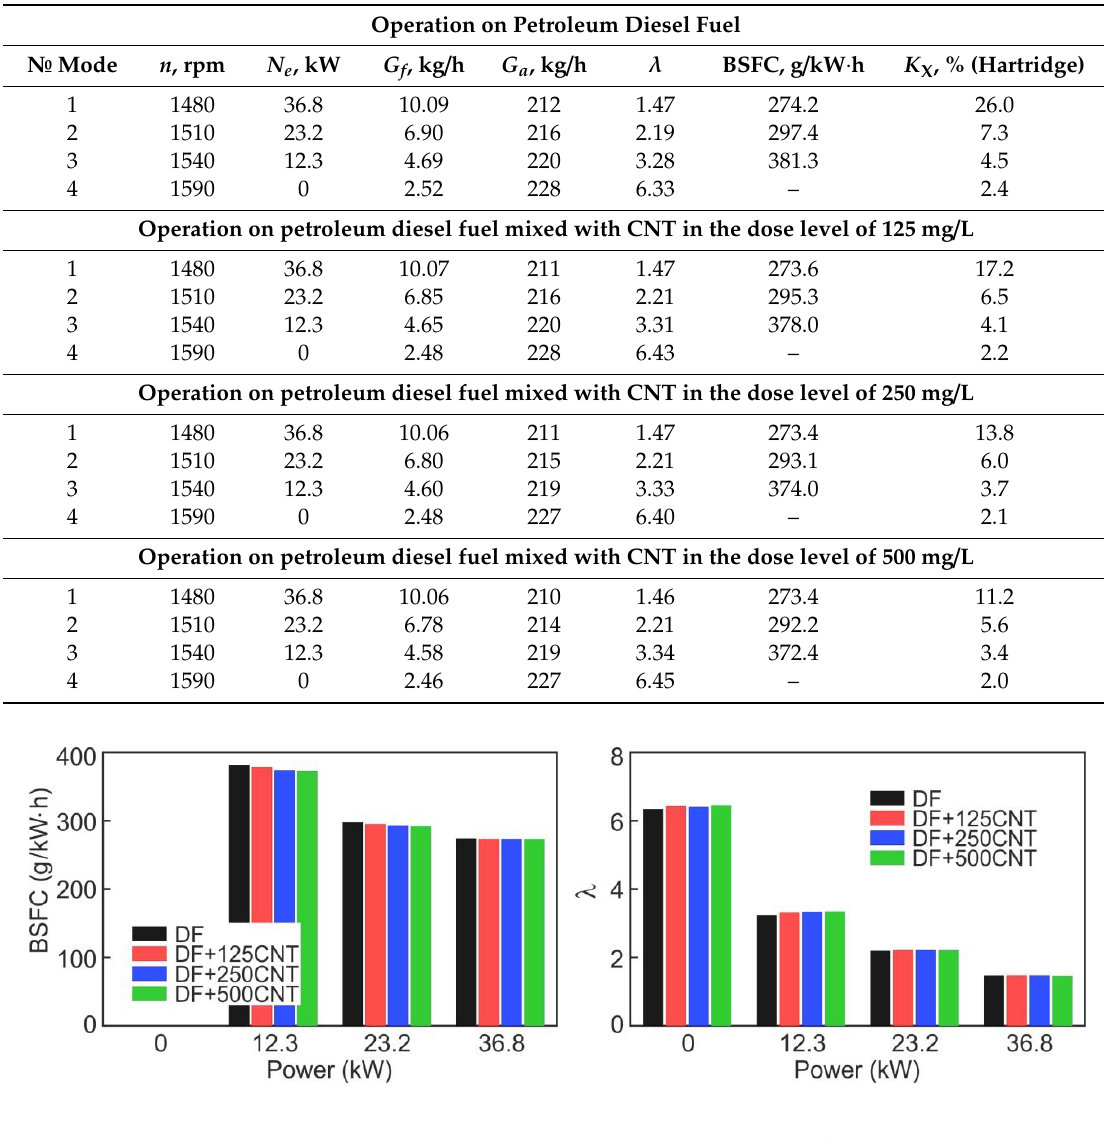
Table 4. The results of exhaust gas emission of the D-243 diesel engine when operating according to the regulatory characteristic. Engine crankshaft speed n , effective power N e , volume concentration of oxygen in exhaust gas C O 2 , carbon dioxide emission C CO 2 , nitrogen oxides emission C NO x , carbon monoxide emission C CO , and hydrocarbon emission C HC . Operation on petroleum diesel fuel № mode